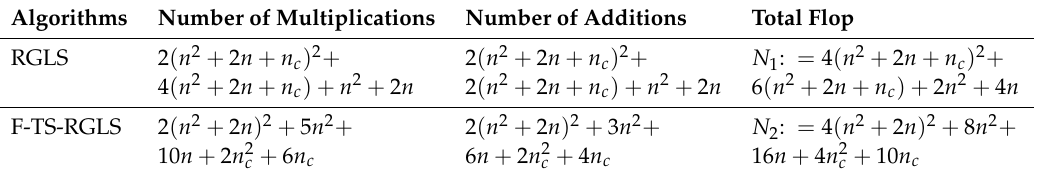
Table 1. The computation efficiency of the recursive least squares (RLS) and filtering-based two-stage RGLS (F-TS-RGLS)